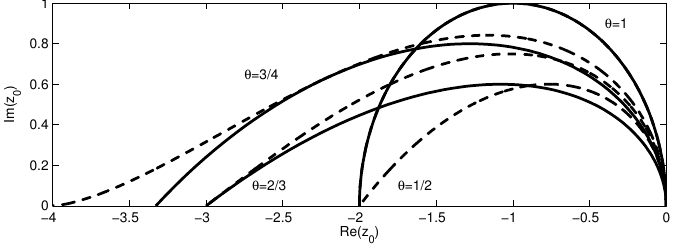
Figure 1. Stability regions S E ( θ ) of explicit methods (dashed lines), and stability regions S π/ 2 ( θ ) of IMEX schemes (solid lines) for θ = 1 / 2, 2 / 3, 3 / 4, and